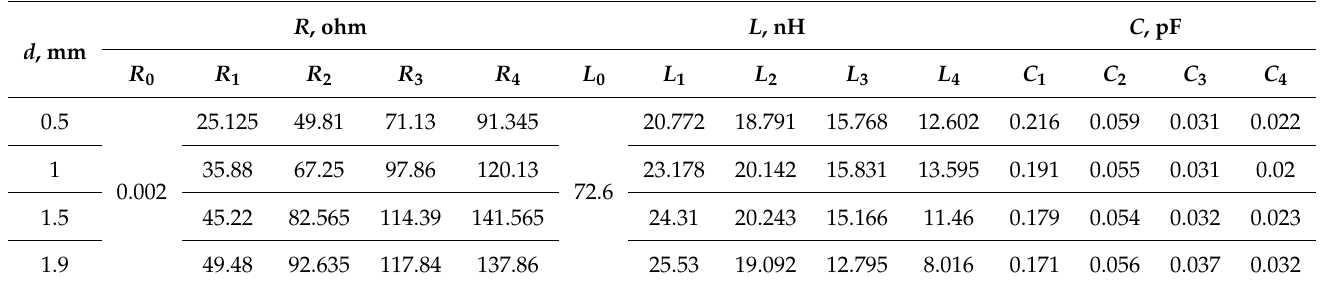
Table 4. Equivalent circuit components for d = 0.5, 1, 1.5, and 1.9